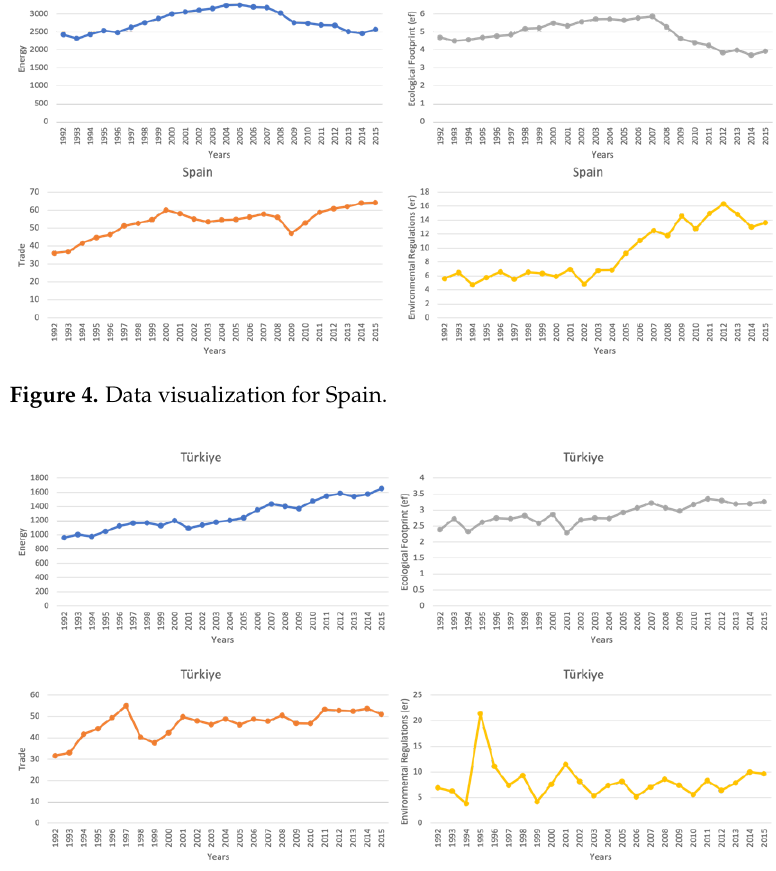
Figure 5. Data visualization for Türkiye.